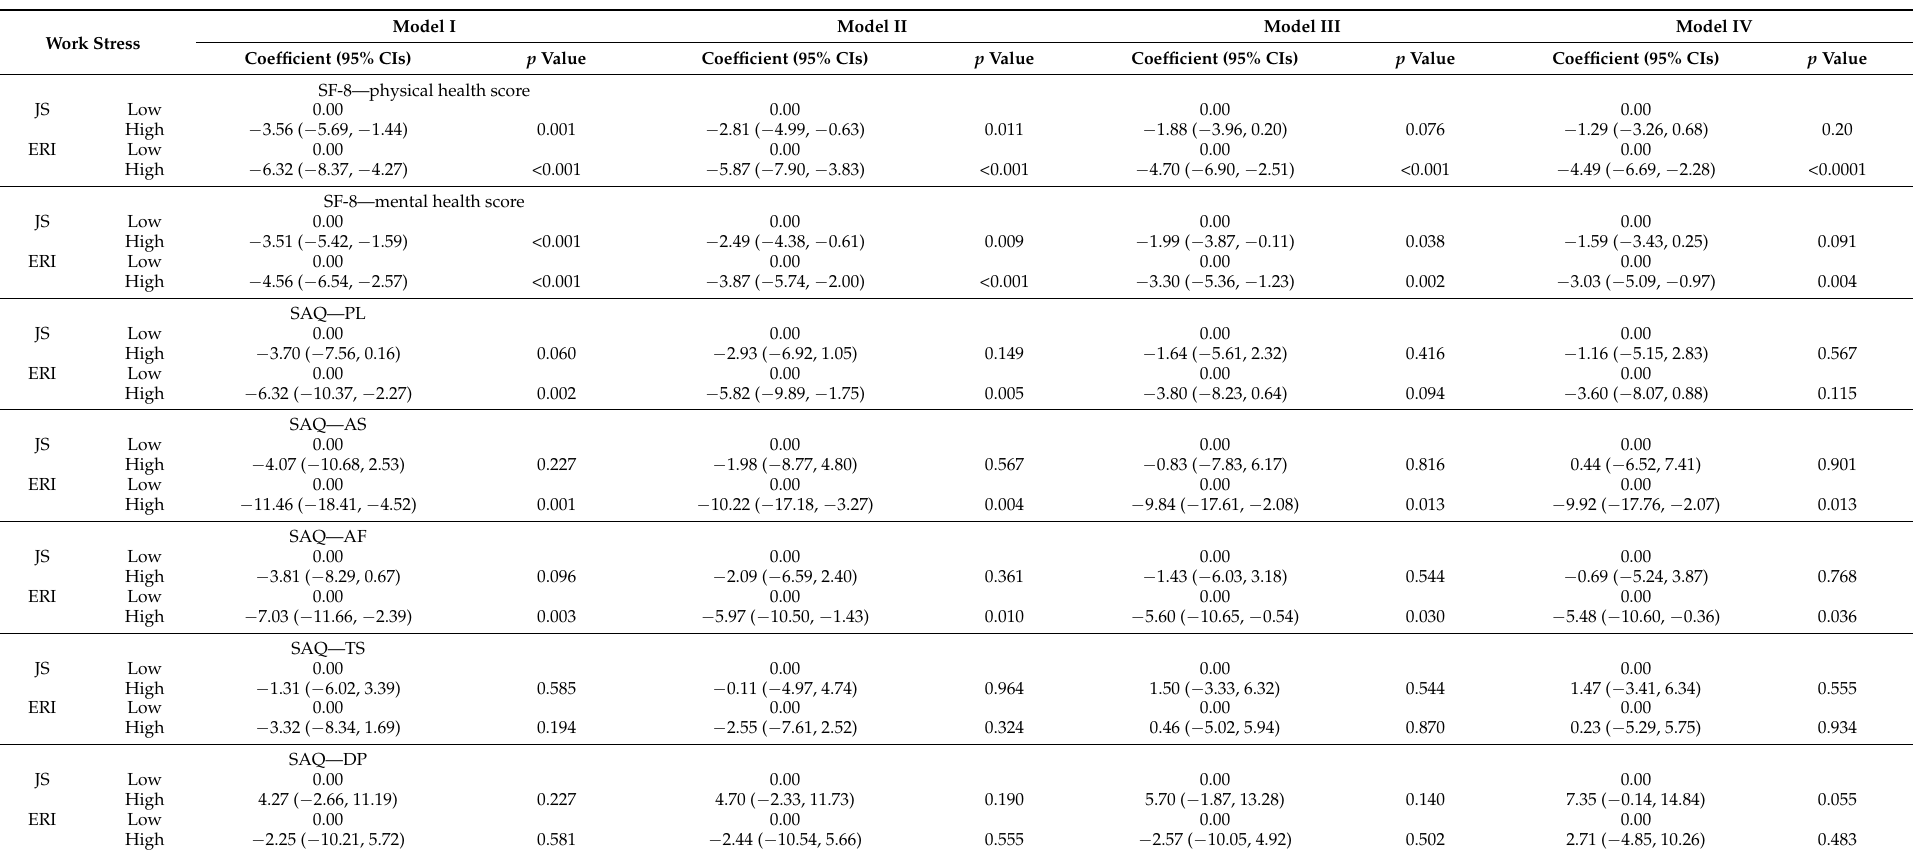
Table 3. The coefficients and 95% CIs of repeated measures of QoL parameters during the one-year follow-up by work stress at the baseline according to job strain and effort–reward